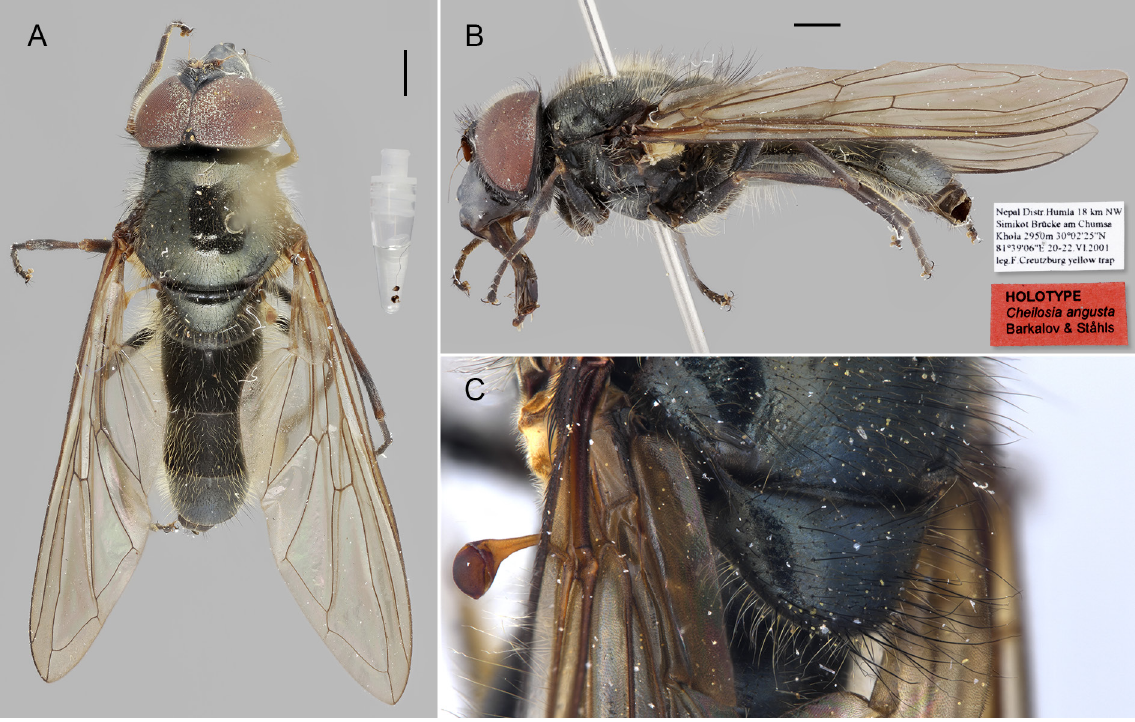
Fig. 8. Cheilosia ( Cheilosia ) angusta sp. nov. A–B . Holotype, ♂ (IBSJW/NME); dorsal and lateral views. C . Oblique view of scutellum of ♂, paratype